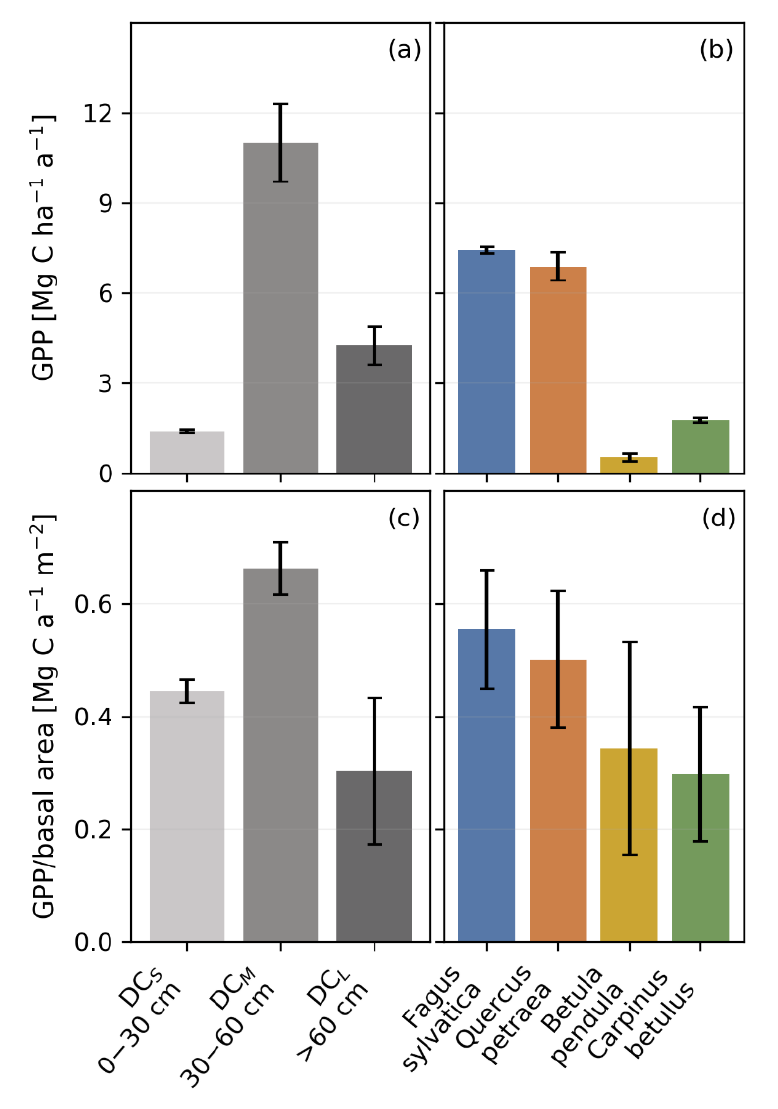
Figure 4. Simulated annual mean productivity GPP ; ( a , b ), as well as productivity per basal area BA; ( c , d ) across three tree size classes and species. The bars indicate the simulated temporal fluctuation throughout the simulation time and simulation runs. Due to the normalization of the index (values between 0.2–0.6), the variability in ( c , d ) seems large due to small changes in GPP and basal area. The productivity index is defined in Section 2.6.